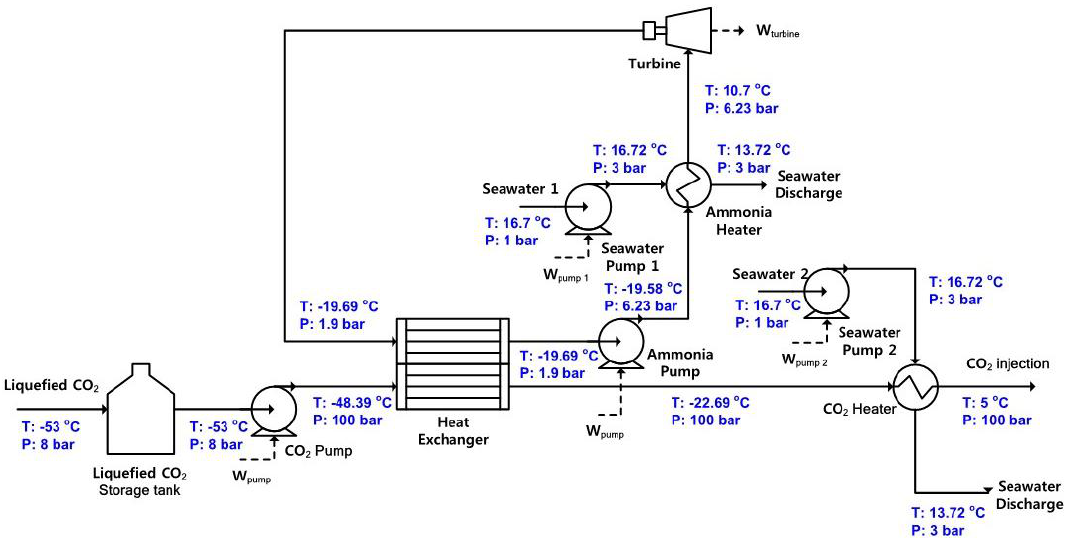
Figure 2. New injection